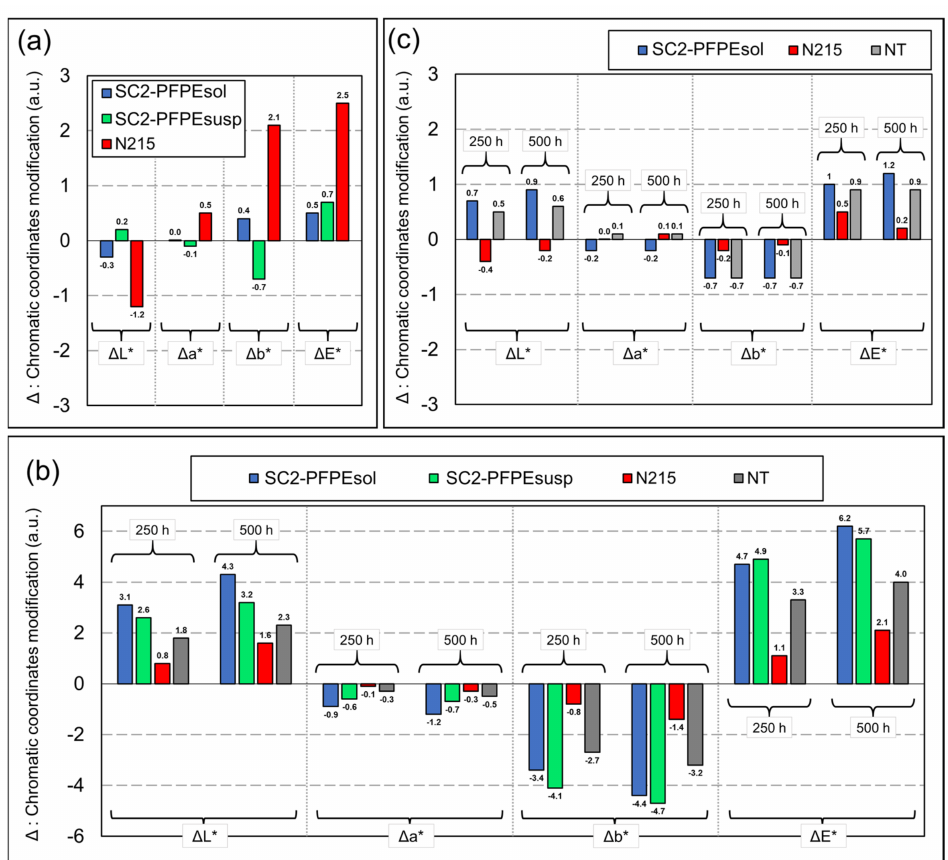
Figure 4. Chromatic modifications of coated stone surfaces: ( a ) after coating on Lecce stone, ( b ) after UV aging on Lecce stone, ( c ) after UV aging on marble. The variation of all the chromatic parameters refers to the same surface before